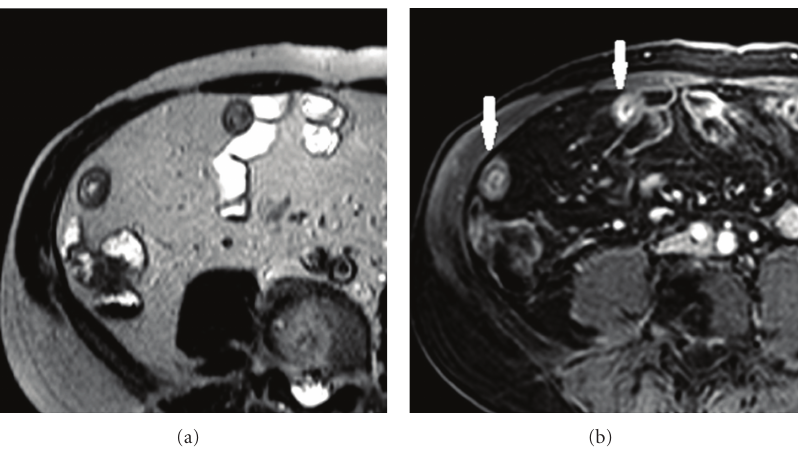
Figure 3: Active inflammation in Crohn’s disease: (a) T2W sequence (HASTE): homogeneous wall thickening with intramural focal hyperintense signal area compliant with active inflammation; (b) postcontrast T1W sequence (VIBE) showing mucosal enhancement with laminar appearance of the wall (with arrows).